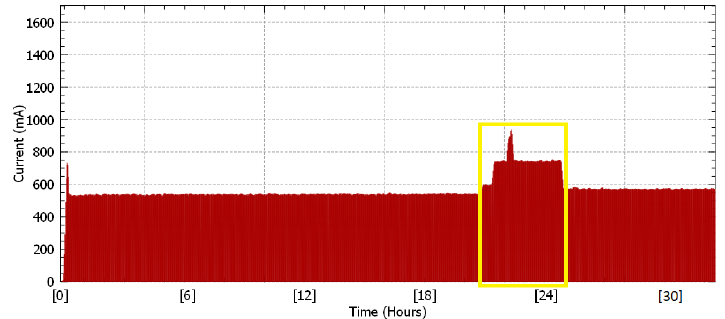
Figure 6. Measurements by applying the first software